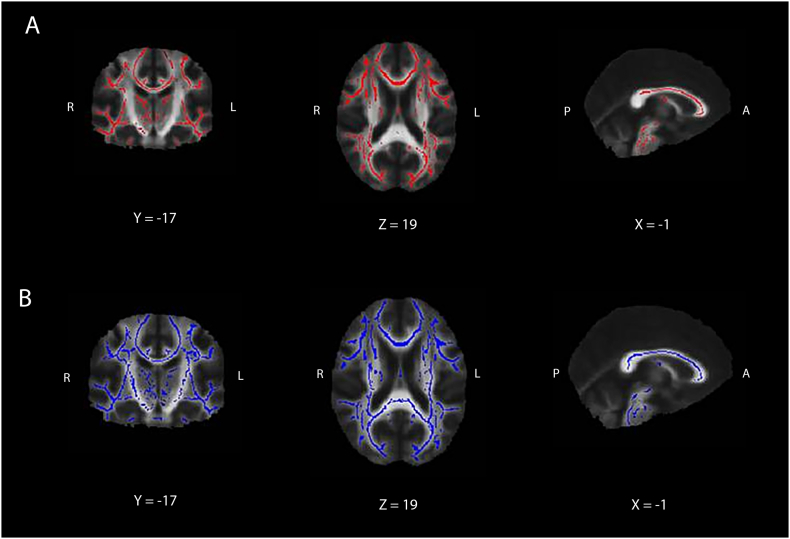
TBSS results. Differences for FA (red, A), MD (blue, B), between DM1 patients and unaffected controls. For both FA and MD, between-group differences can be seen widely dispersed throughout the brain and present in association, projection and commissural fibre systems (p < 0.05, corrected for multiple comparisons). (For interpretation of the references to color in this figure legend, the reader is referred to the web version of this article.)